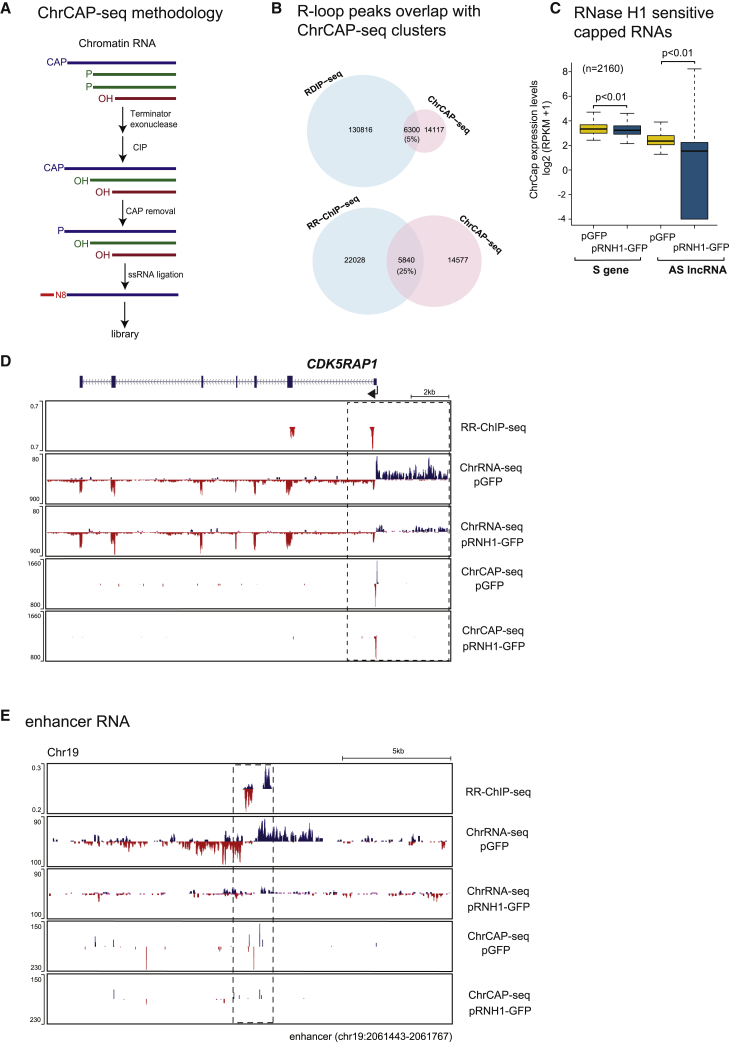
Cap Analysis of RNase H1-Sensitive Transcripts(A) Schematic of ChrCAP-seq methodology.(B) Overlap with CAP clusters of RDIP-seq peaks (top) and RR-ChIP-seq peaks (bottom).(C) Boxplots showing expression level distribution for S and AS CAP signal for ChrCAP-seq clusters that overlap with AS transcript and are sensitive to RNase H1 overexpression. Statistical significance between distribution of medians assessed using the Wilcoxon test.(D) CDK5RAP1 displays RNase H1 capped sensitive 5'AS lncRNA.(E) Chromosome 19 enhancer displays capped RNase H1-sensitive eRNA.